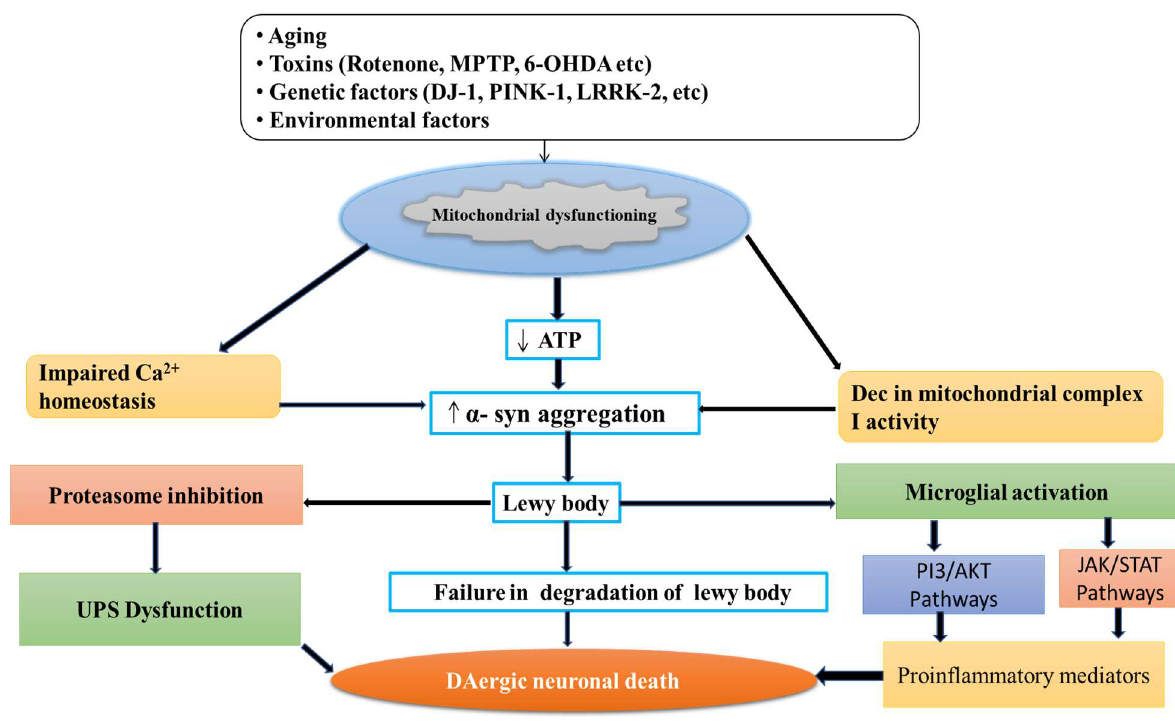
Figure 2. Degeneration of DAergic neuronal death by different neurotoxins.